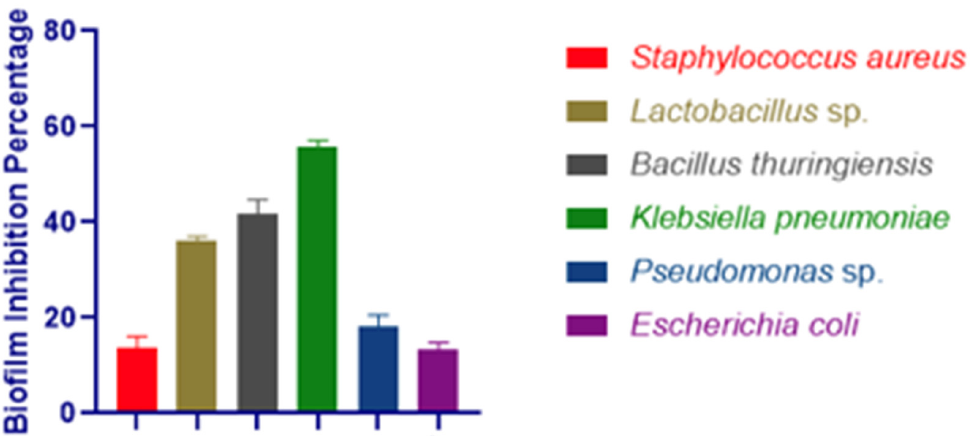
Figure 1. Biofilm inhibition by the CFS from Staphylococcus aureus , Lactobacillus sp., Bacillus thuringiensis , Klebsiella pneumoniae , Pseudomonas sp. and Escherichia coli .